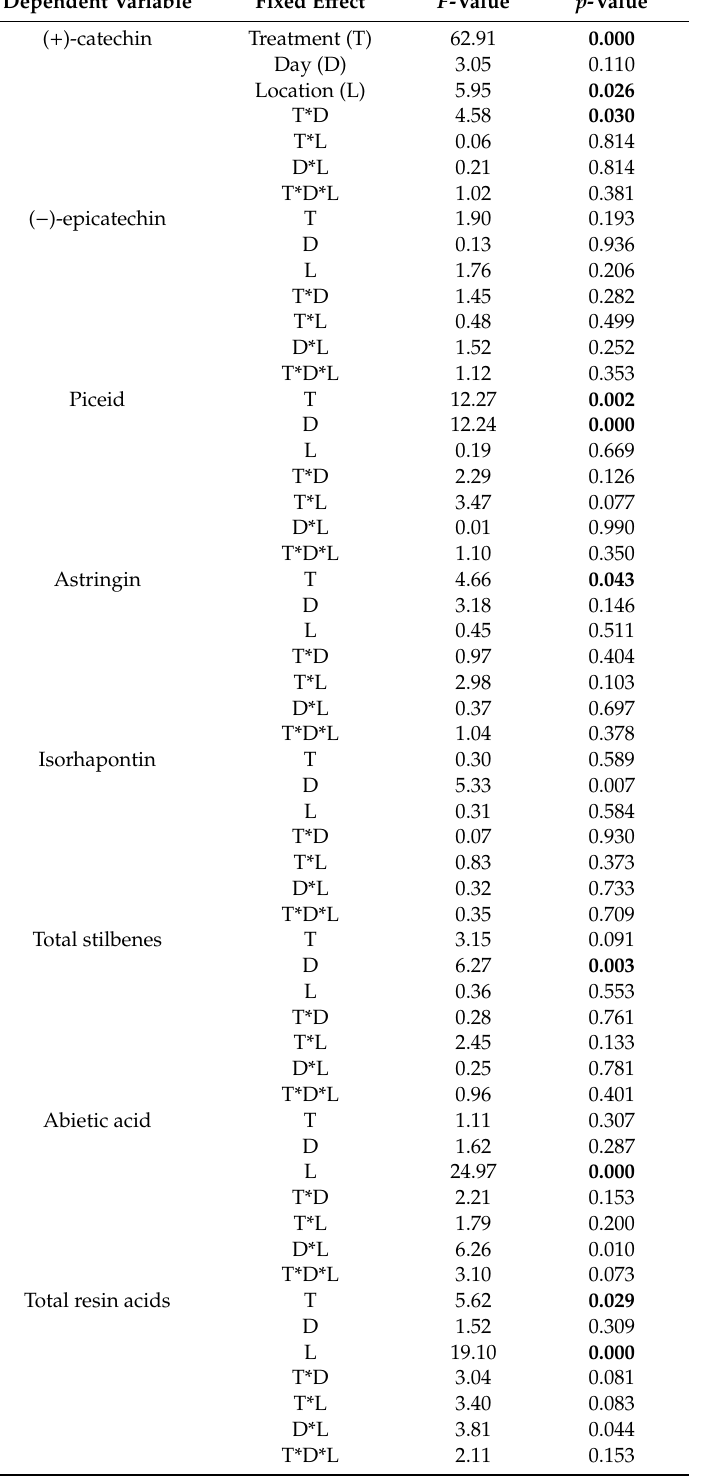
Table 1. Mixed model results from testing the di ff erences between treatments (i.e., unwounded control, wounding, and fungal inoculation with Endoconidiophora polonica ), time after treatment onset (day), and location on the stem (i.e., distance from the treated site: 5 mm and 10 mm) in terms of the quantitative amounts of ( + )-catechin, ( − )-epicatechin, stilbene glucosides, and resin acids in the phloem and bark of Norway spruce